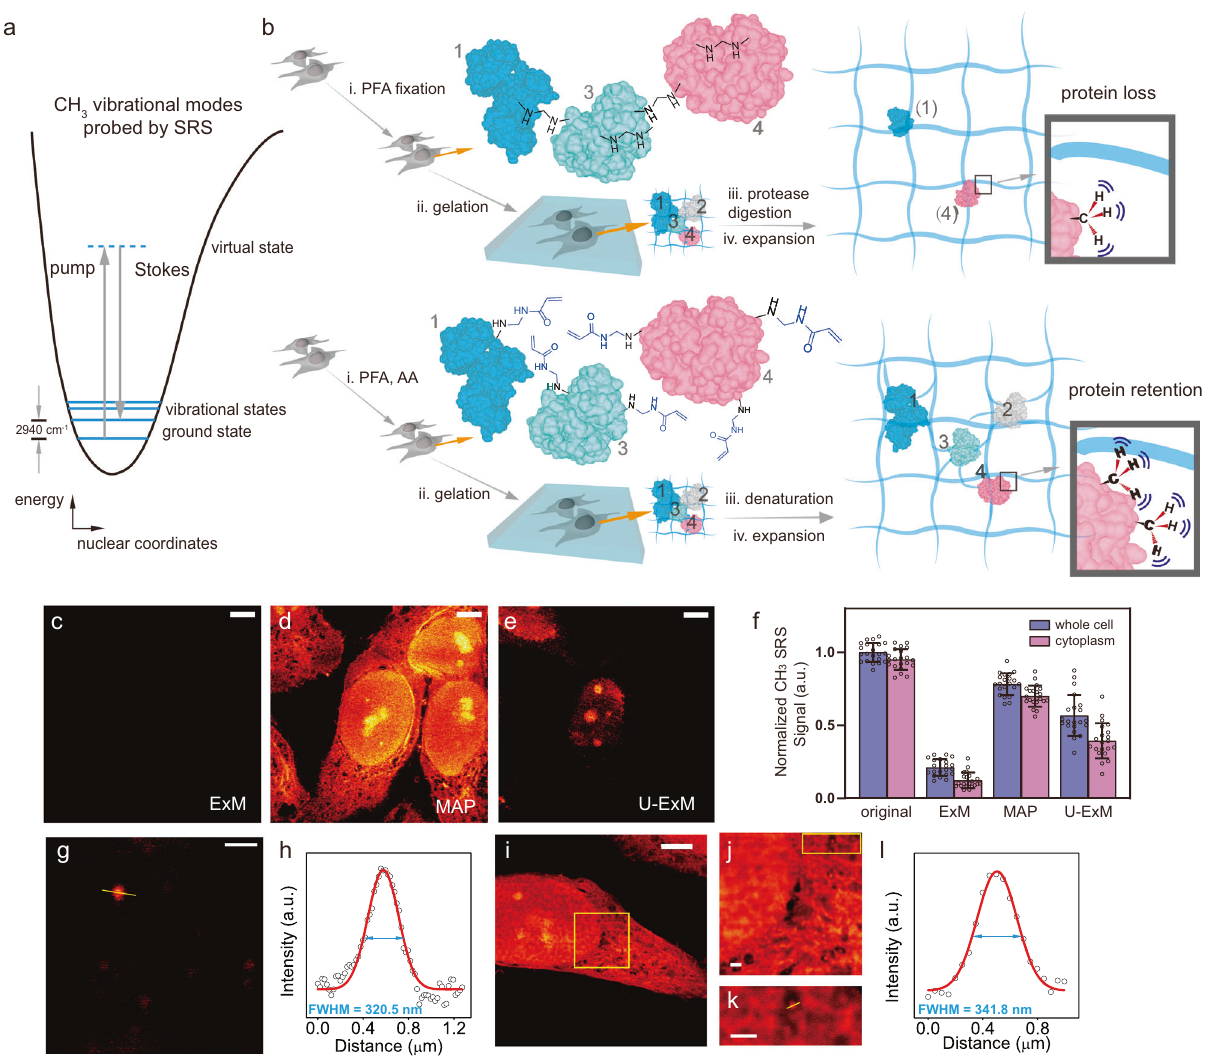
Fig. 1 High-resolution label-free vibrational imaging of expanded and protein-retained samples. a Energy scheme for SRS probing of CH 3 vibrational motion at 2940 cm − 1 . More details in Supplementary Fig. 1. b Comparison of protein retention (i.e., the methyl groups, CH 3 , from proteins) for SRS imaging between ExM (top) and MAP (bottom) based sample-hydrogel embedding procedures following different fi xation, hybridization, and homogenization chemistries. c – e SRS imaging of CH 3 at 2940 cm − 1 for expanded HeLa cells following ExM, MAP, and U-ExM sample treatment under the same